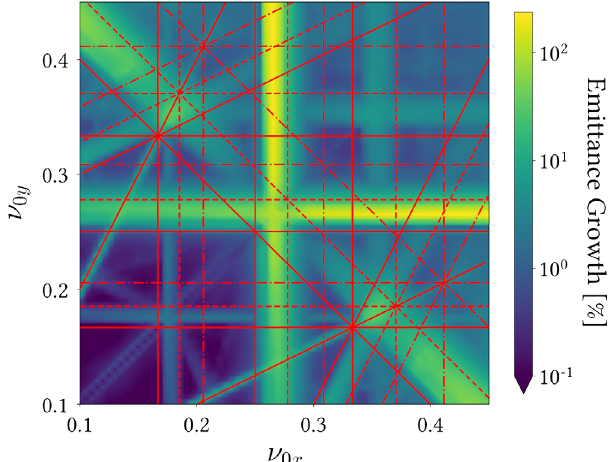
FIG. 3. Tune diagram obtained from 2D W ARP simulations under the initial condition η x ¼ η y ¼ 0 . 9 . The rates of rms emittance growth evaluated at 5000 different operating points after 100 AG cells are color-coded in the tune diagram. The external beam-focusing force is completely linear, which varies sinusoidally along the transport channel. The abscissa and ordinate represent the horizontal and vertical bare tunes per AG cell. The initial particle distribution is the Gaussian type well matched the AG potential. The solid, dashed, and dash-dotted lines in the picture are obtained from Eq. (10) with the incoherent Þ , respectively. tune shifts Δ ν x ð y Þ ¼ 0 , Δ ¯ ν x ð y Þ , and max ð Δ ν Gauss x ð y Þ We have assumed that all visible emittance-growth bands are due to the linear ( m ¼ 2 ) and first nonlinear ( m ¼ 3 ) resonances. Two of the four third-order coupling resonance lines are independent of the C m factor because they correspond to the n 0 ¼ 0 case in Eq. (9). A scalloped appearance of these coupling resonance bands is due to the limited density of PIC data